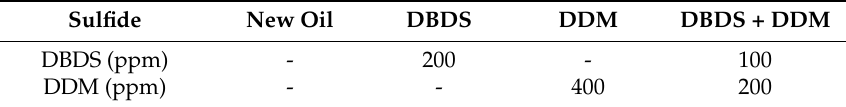
Table 5. Concentration of sulfides added in oil